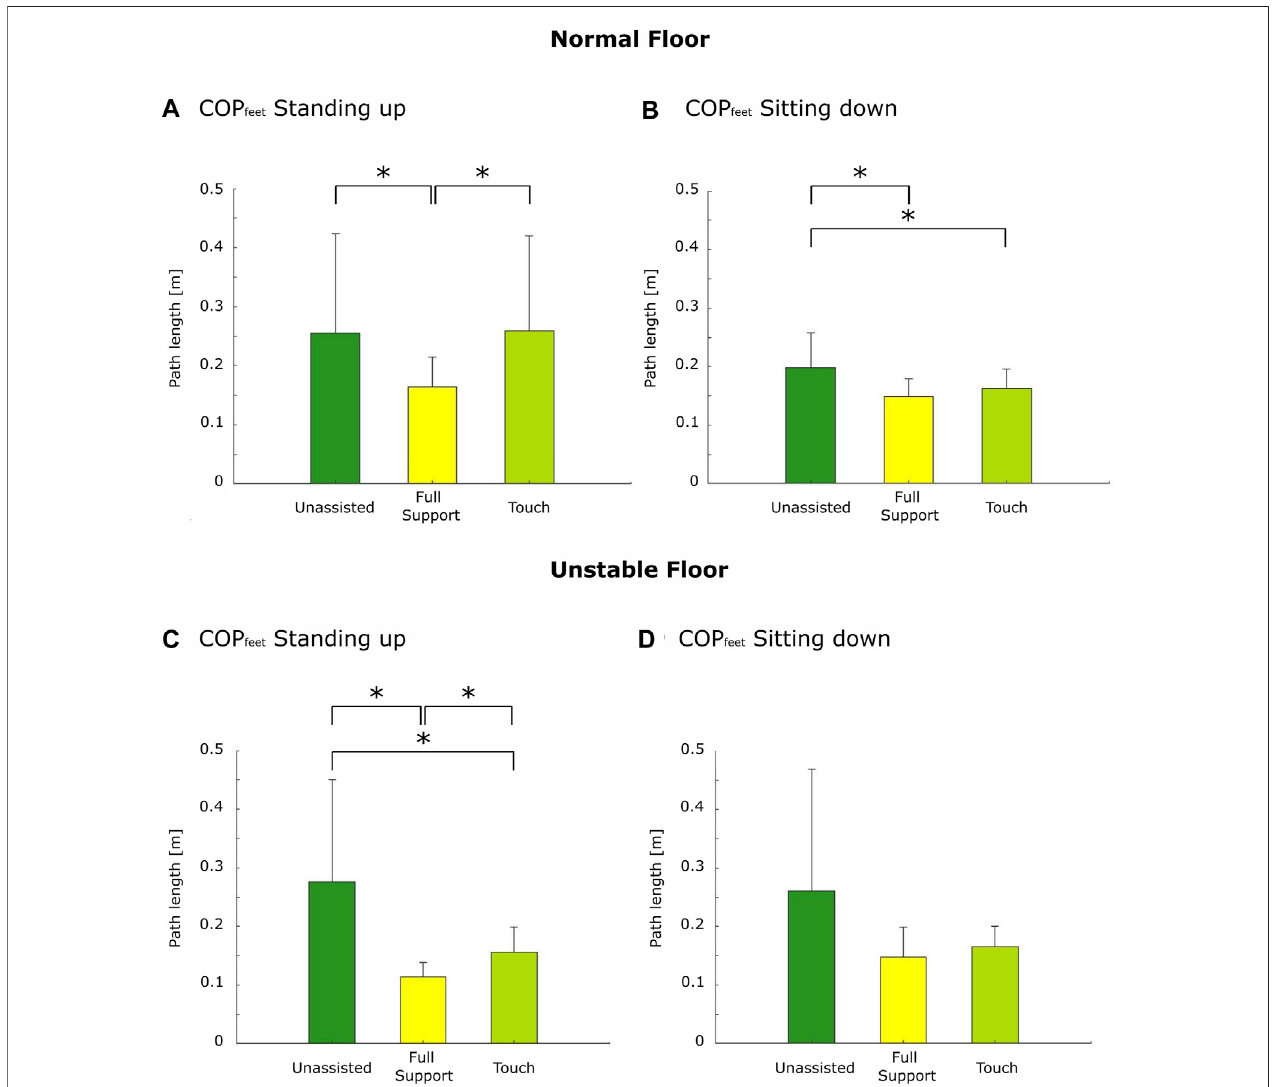
FIGURE 3 | Center of pressure trajectory length. Standing up under normal fl oor (A) and unstable fl oor conditions (C) and sitting down under normal (B) and unstable fl oor conditions (D) . The asterisk depicts post hoc signi fi cant differences with p ≤ 0.05 (Holm – Bonferroni corrected).